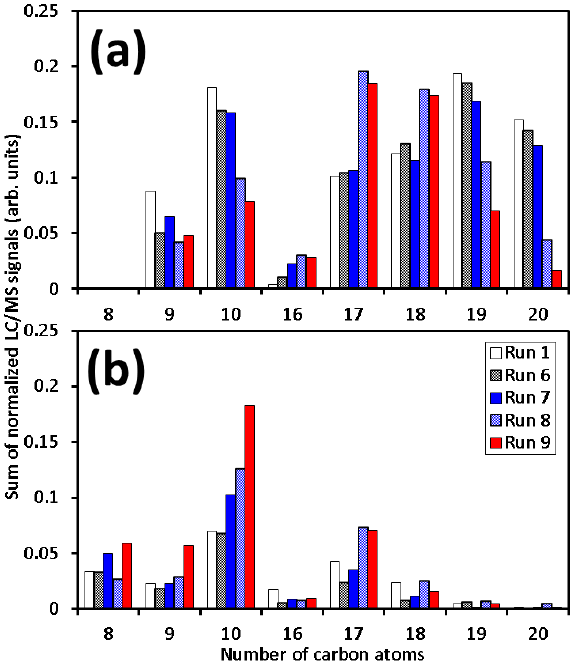
Figure 3. Carbon number distributions determined for particle products at (a) carbon oxidation state < − 0 . 6 (less oxygenated than HOMs) and (b) carbon oxidation state ≥ − 0 . 6 (HOMs); abundance was directly calculated from the summation of normalized signal